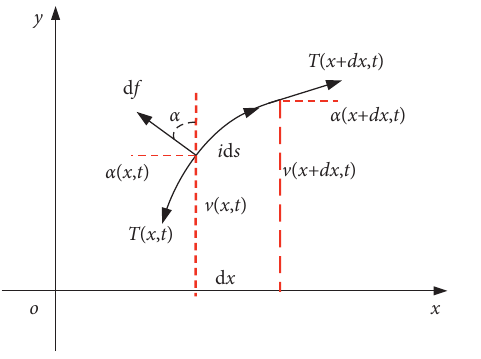
Figure 2: Infinitesimal force diagram of current-carrying